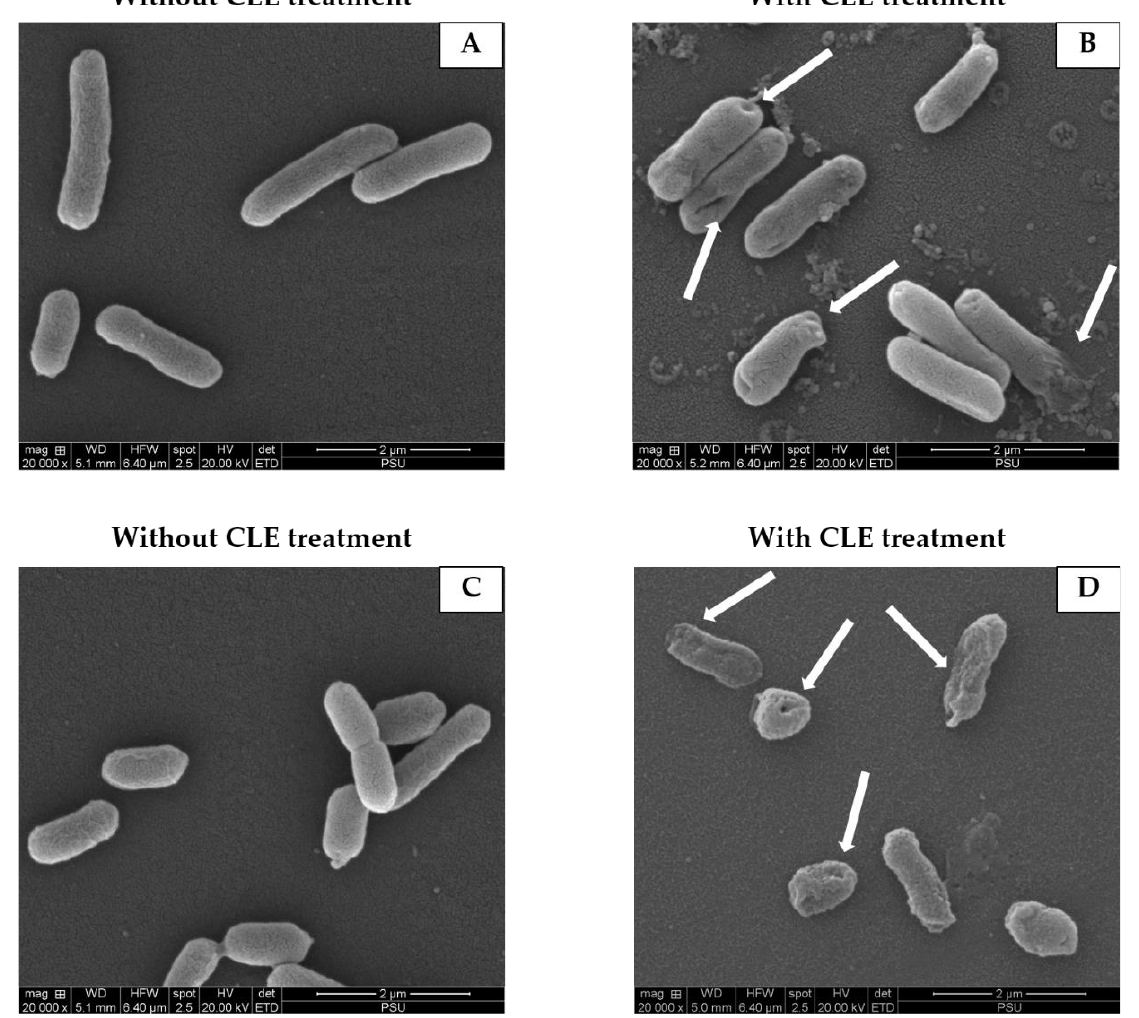
Figure 5. Scanning electron micrographs of P. aerugenosa ( A , B ) and Shewanella sp. ( C , D ) without and with CLE treatment at 1 MIC using CLE. Magnification: ×20,000. Arrow signs indicate pore or disrupt membrane.